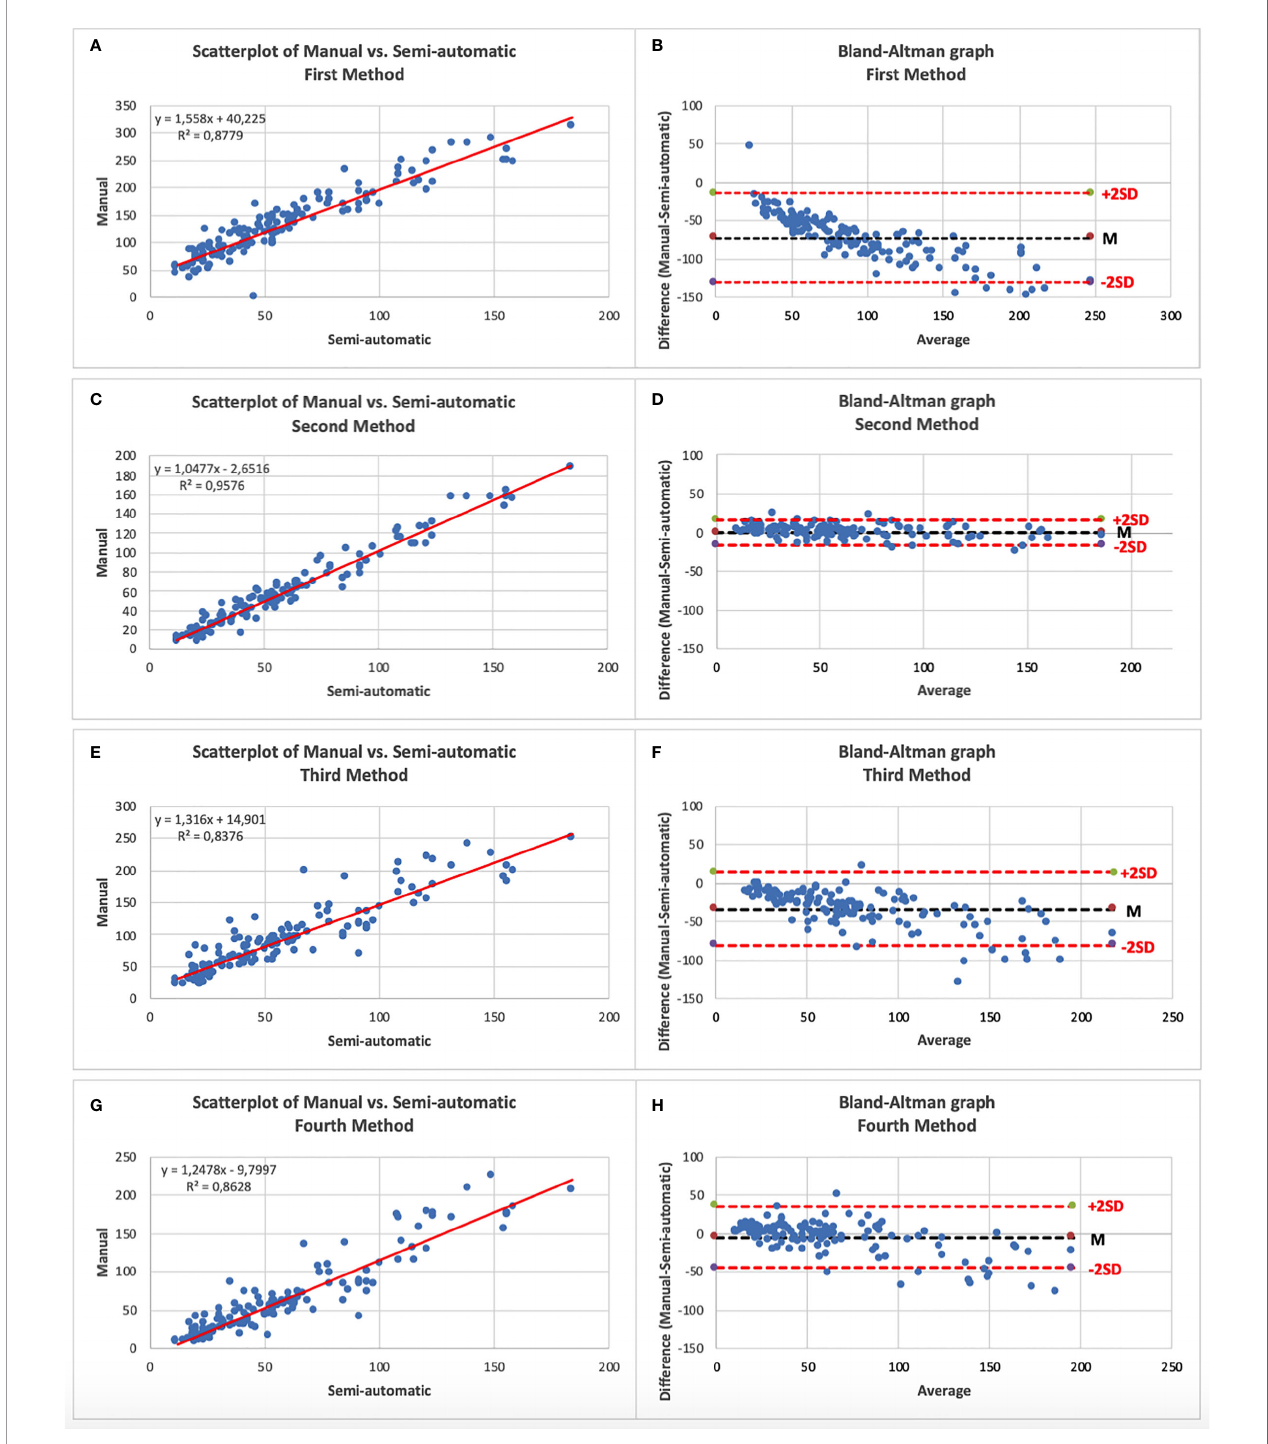
FIGURE 3 | (A) Scatterplot of Manual vs. First semi-automatic method; (B) Bland – Altman graphic of Manual vs. First semi-automatic method; (C) Scatterplot of Manual vs. Second semi-automatic method; (D) Bland – Altman graphic of Manual vs. Second semi-automatic method; (E) Scatterplot of Manual vs. Third semi- automatic method; (F) Bland – Altman graphic of Manual vs. Third semi-automatic method; (G) Scatterplot of Manual vs. Fourth semi-automatic method; (H) Bland – Altman graphic of Manual vs. Fourth semi-automatic method. — An excellent correlation can be noted on all scatterplots. Note on the Bland – Altman graphs the high variability of the differences between the two counting modalities in the methods 1, 3 and 4 compared to the little variability in method 2 (narrower cloud of